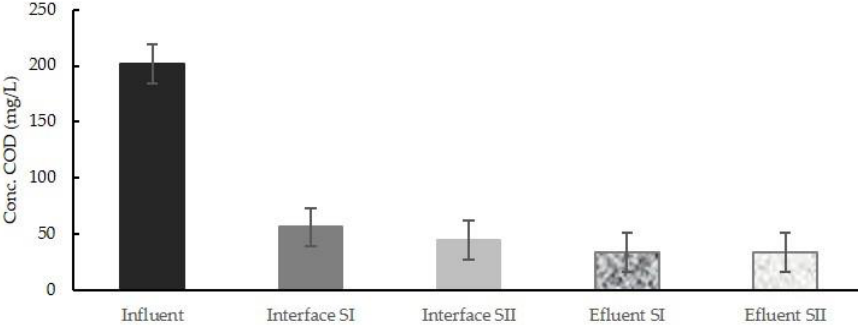
Figure 4. Behavior of COD at three points of the systems during the last 23 weeks of the study.